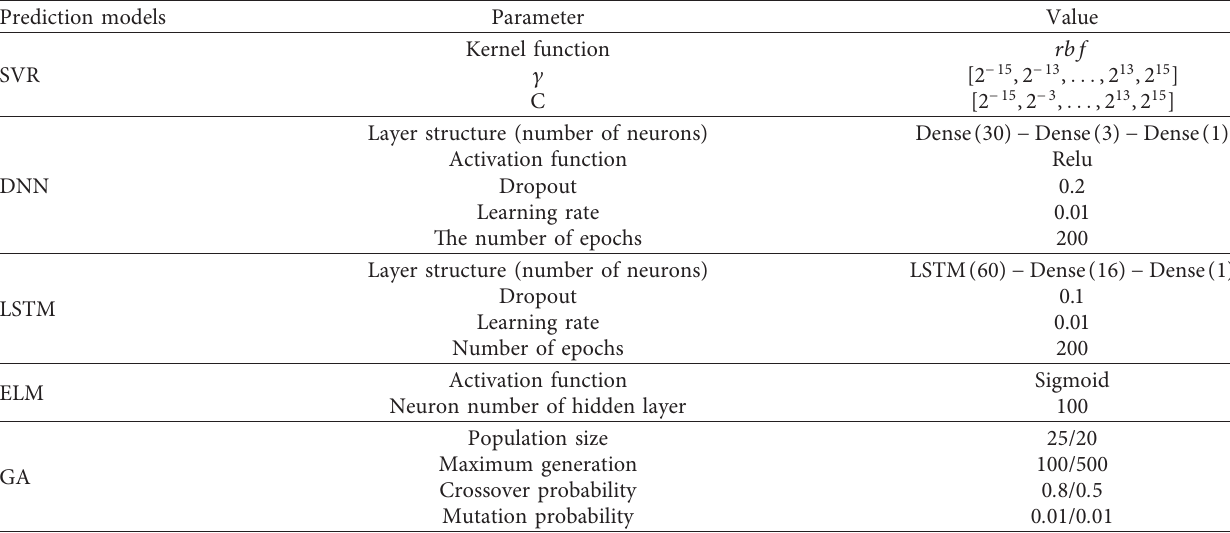
Table 2: Parameter settings of different models.